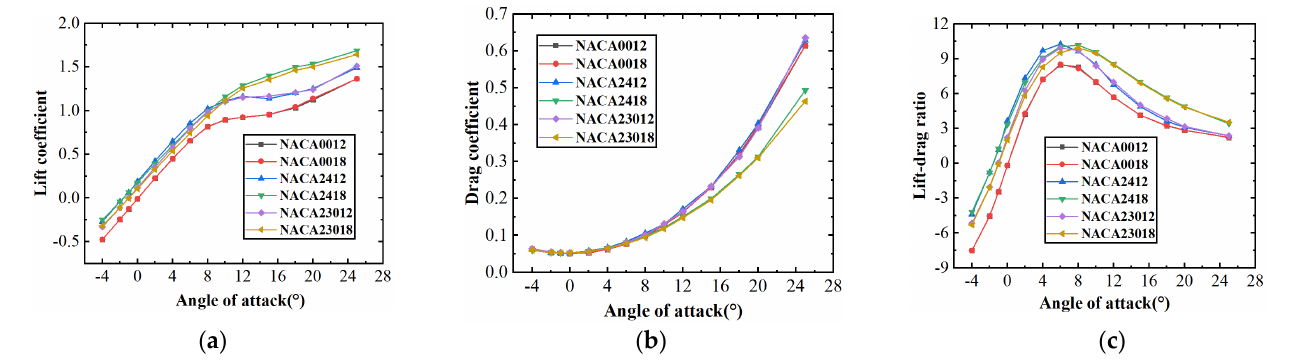
Figure 10. Hydrodynamic calculation results of the rhomboid wing with di ff erent types of airfoils, lift coe ffi cient ( a ), drag coe ffi cient ( b ), and lift–drag ratio ( c ).